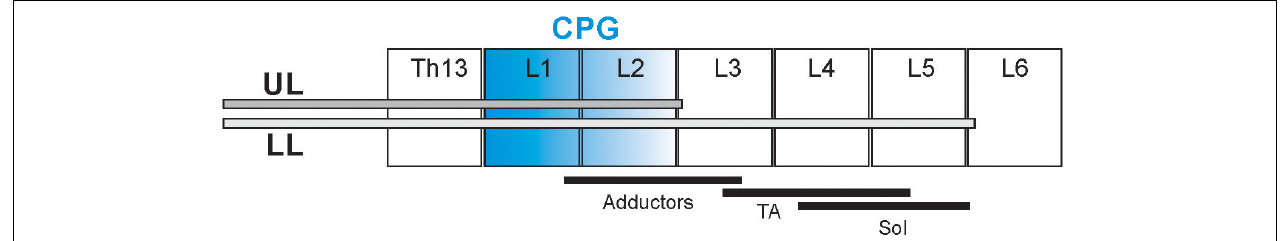
FIGURE 1 | Schematic diagram presenting the cannula tip location in the spinal cord in two groups of rats: upper lumbar (UL) and low lumbar (LL) spinal segments. The black lines below the different spinal cord segments (L2–L5) present schematically the distribution of the motoneurons innervating soleus (Sol), tibialis anterior (TA), and adductor muscles (Add) (Nicolopoulos-Stournaras and Iles, 1983; Sławi´nska et al., 1995). The segments in blue indicate the hypothetic location of the neural network of the Central Pattern Generators (Cazalets et al., 1995; Jordan and Schmidt, 2002).